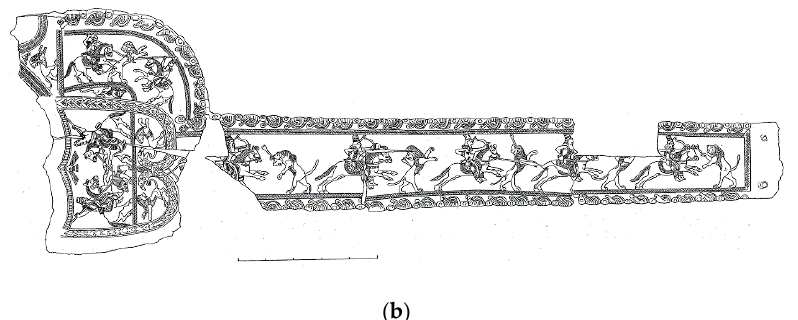
Figure 29. ( a ) Ceremonial sheath for scabbard (BM inv. no. 123923; reg. no. 1897,1231.22); armour, gold; found at Takht-i Kuwad (?) (Oxus Treasure), Tajikistan; Achaemenid, ca. 5th cent. BCE (?). [Images courtesy of the Trustees of the British Museum, London]; ( b ) line drawing of preceding (as above).